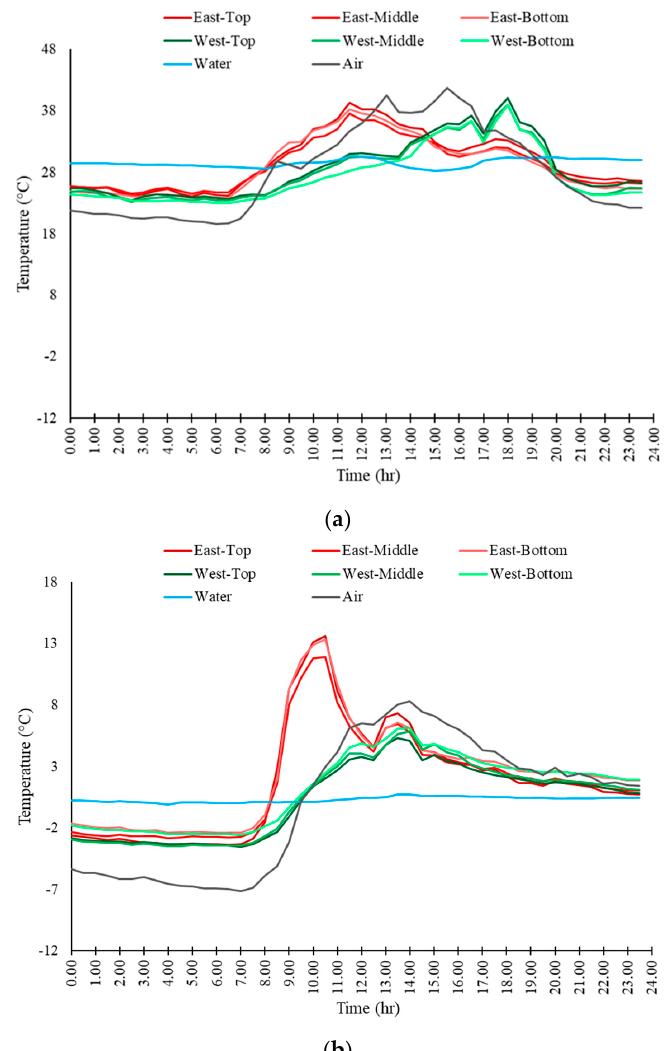
Figure 6. Temperatures of the HDPE tank, water, and ambient on two sunny days during ( a ) summer and ( b ) winter measured via attached